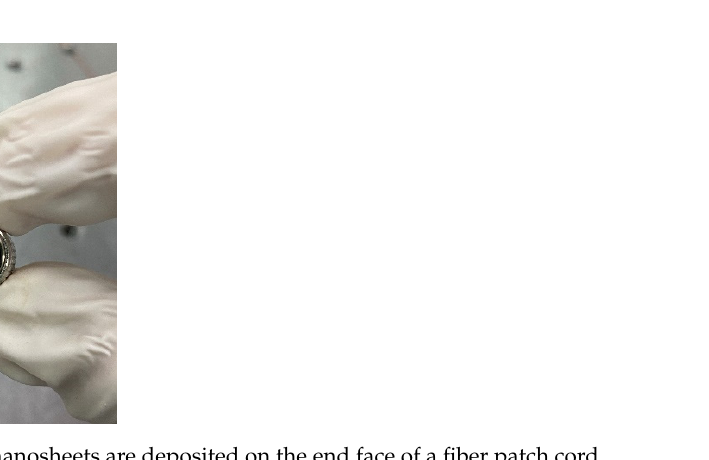
Figure 2. Fe 3 O 4 nanosheets are deposited on the end face of a fiber patch cord.